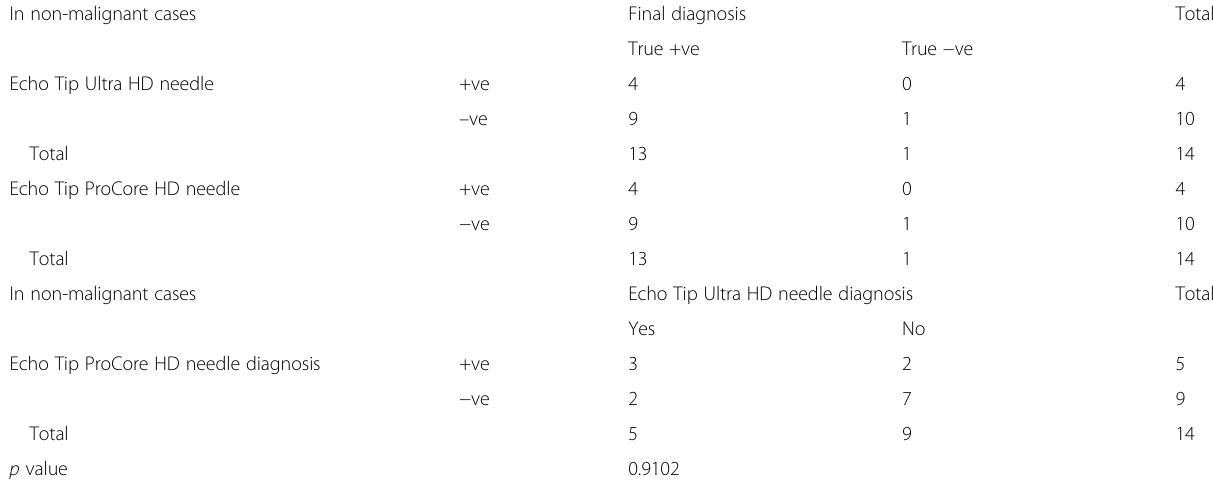
Table 4 Sensitivity, specificity, predictive value, and diagnostic accuracy of both needles in non-malignant cases In non-malignant